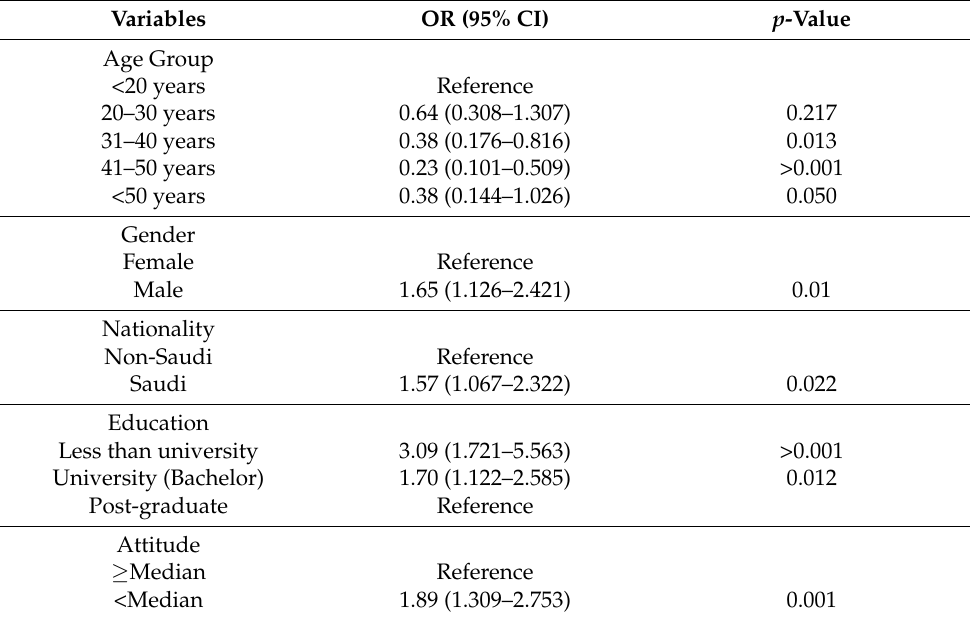
Table 5. Logisic regression predicting lower social and Islamic practice scores during COVID-19 pandemic in KSA.